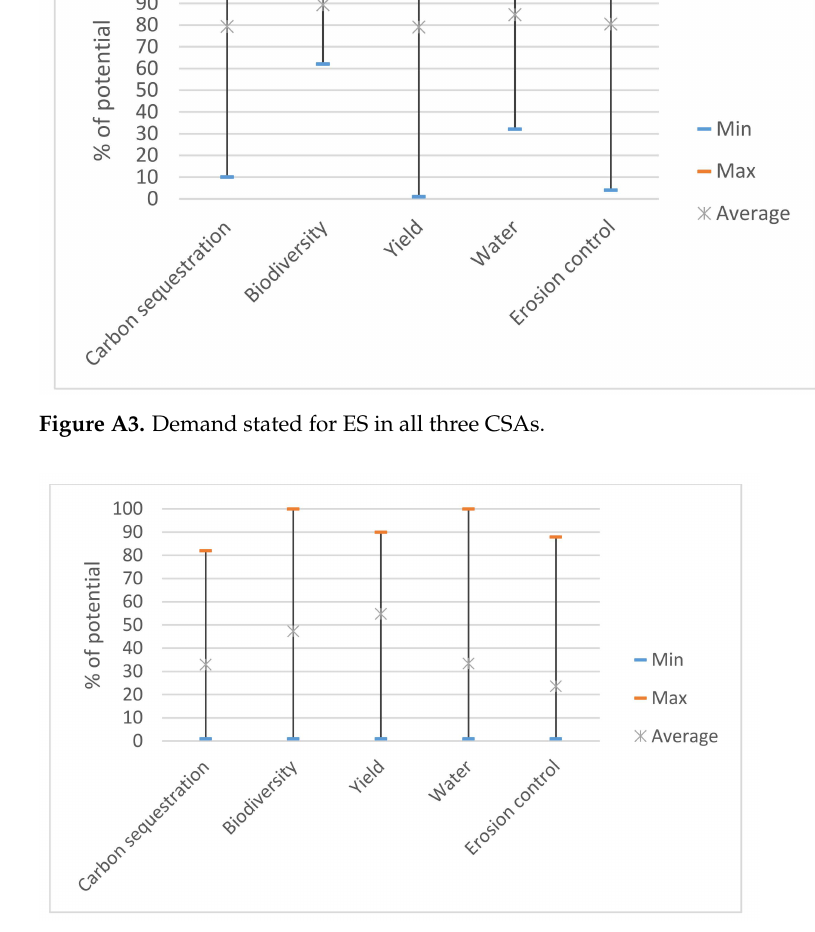
Figure A4. Supply perceived for ES in all three